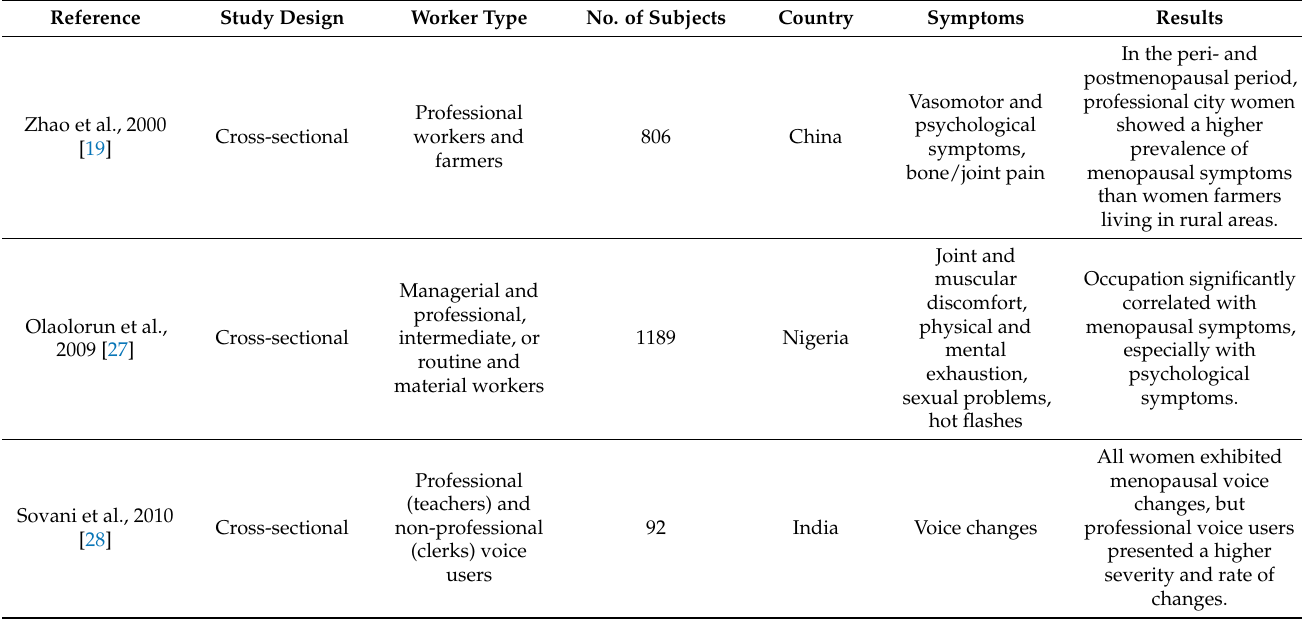
Table 4. Studies evaluating work and menopausal